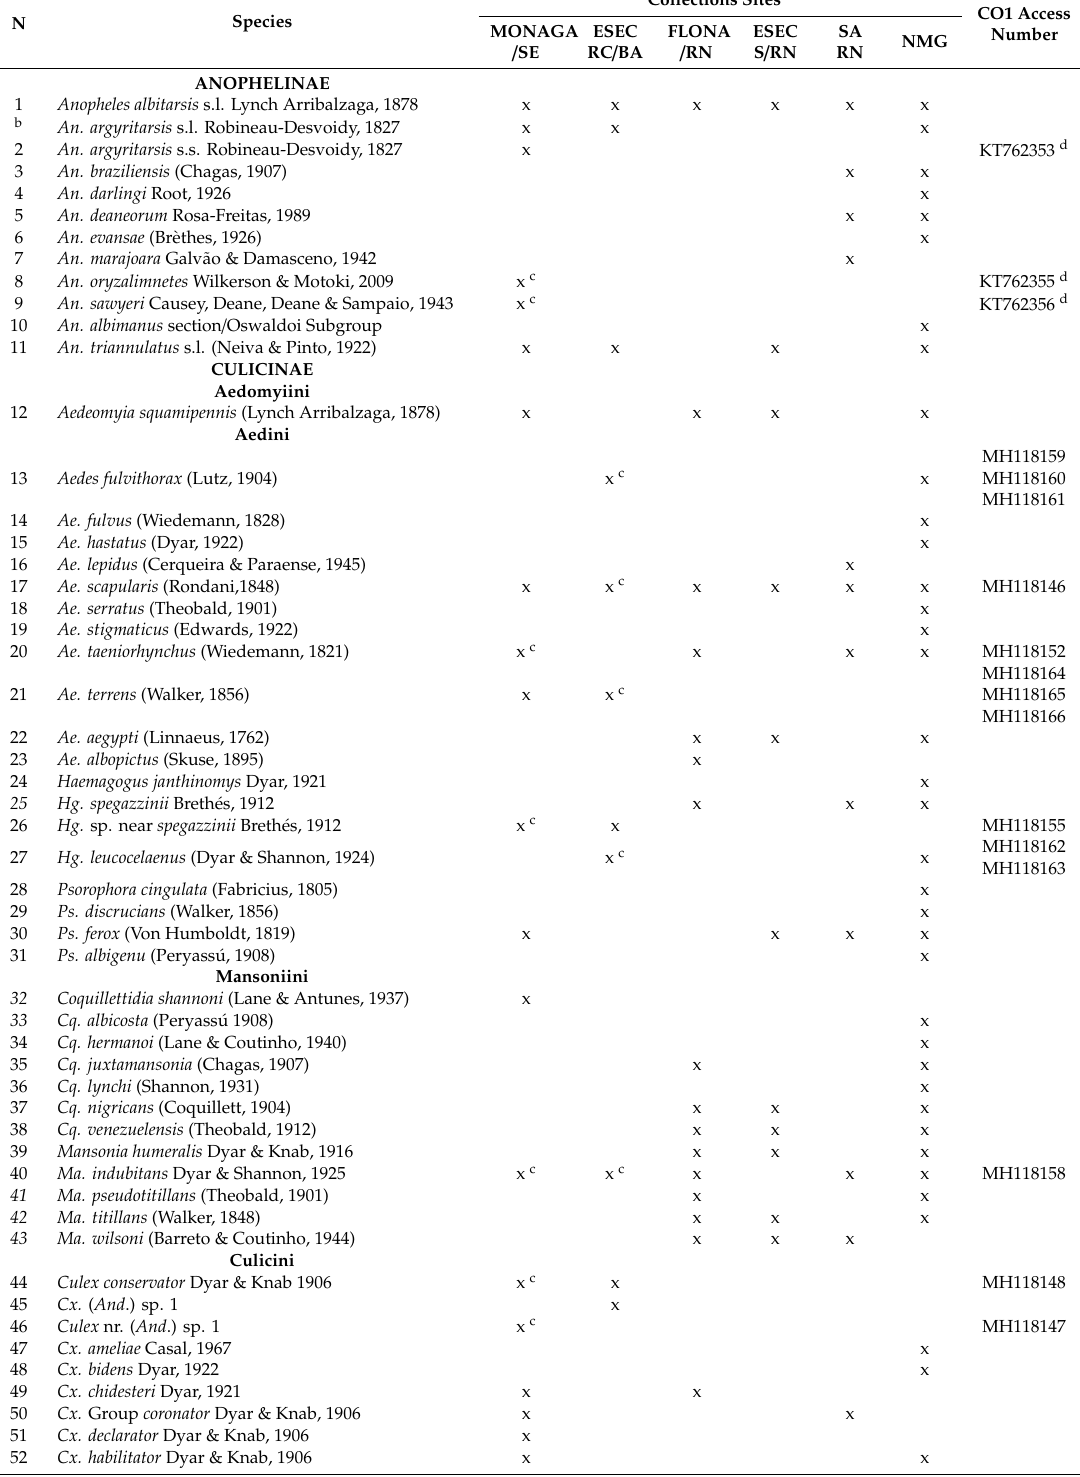
Table 2. Checklist of the regional diversity of Culicidae gathered from surveys conducted in protected areas in the Caatinga biome between 2008 and